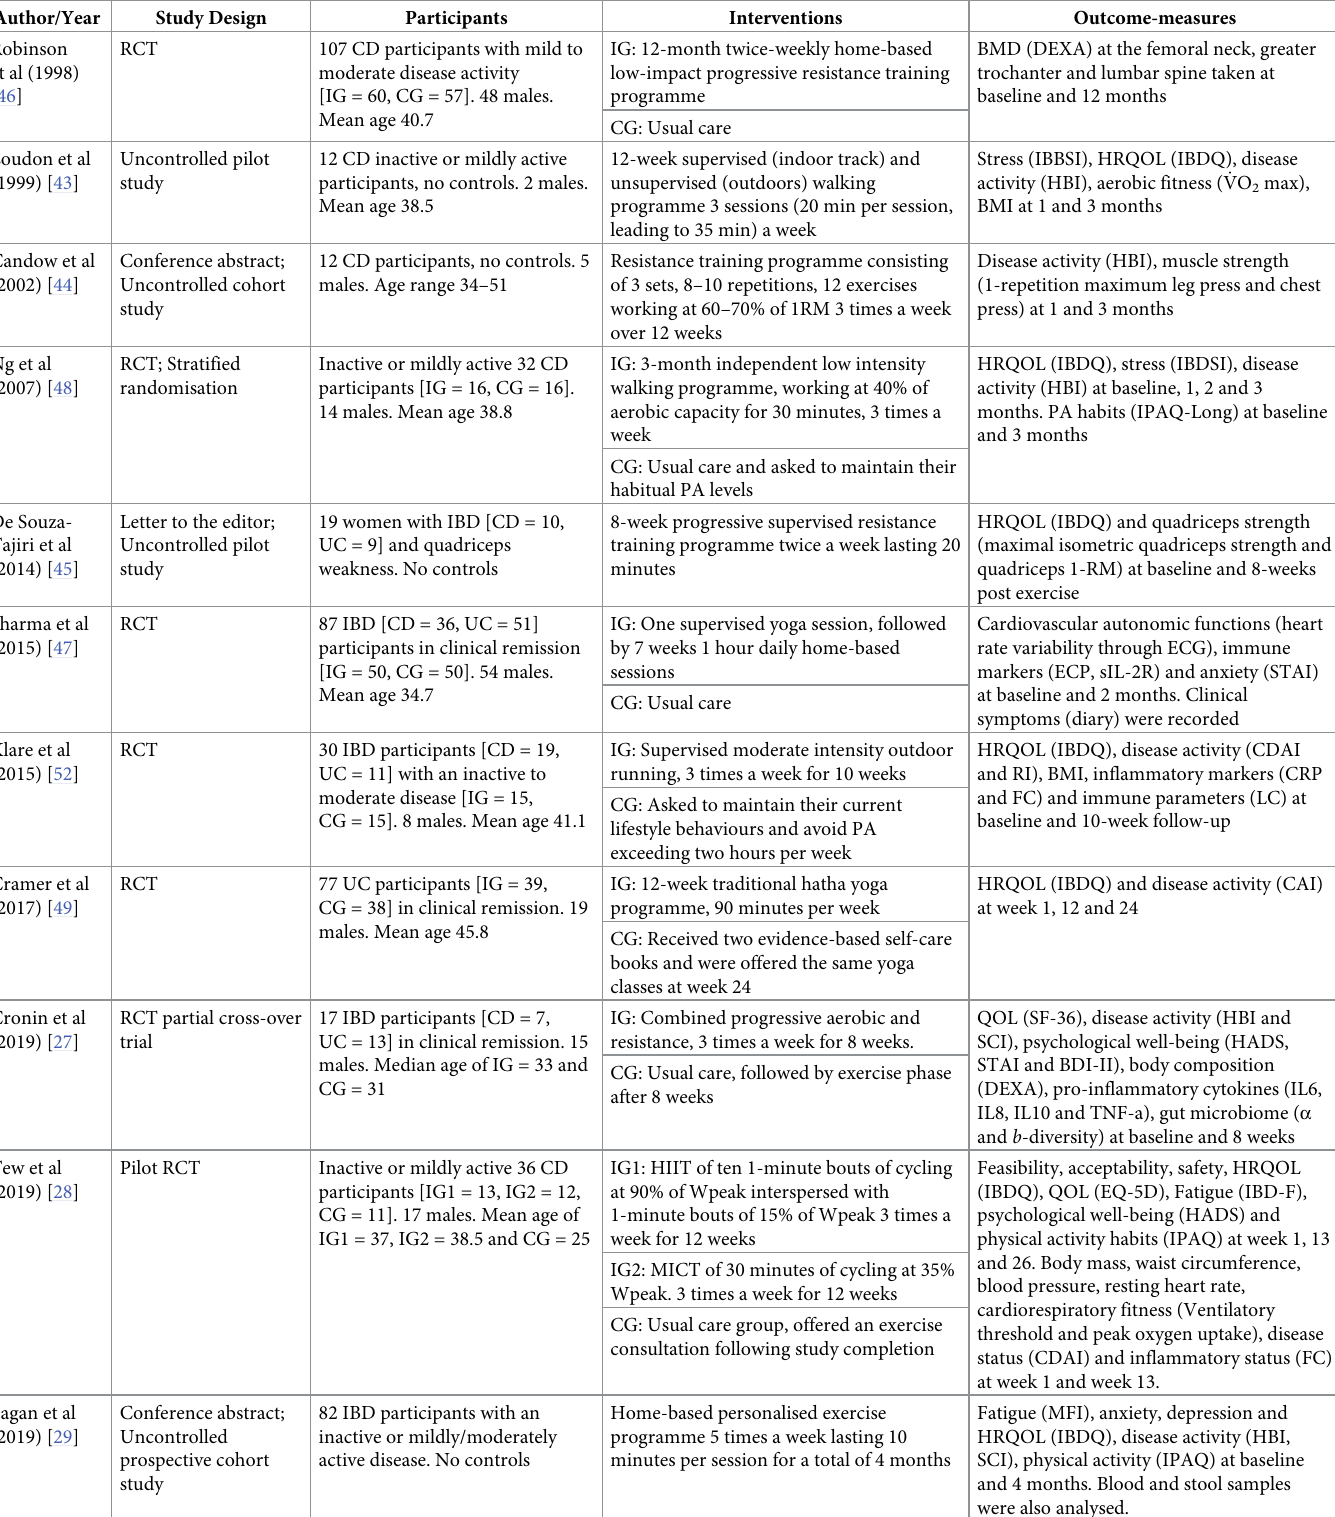
Table 1. Characteristics of included